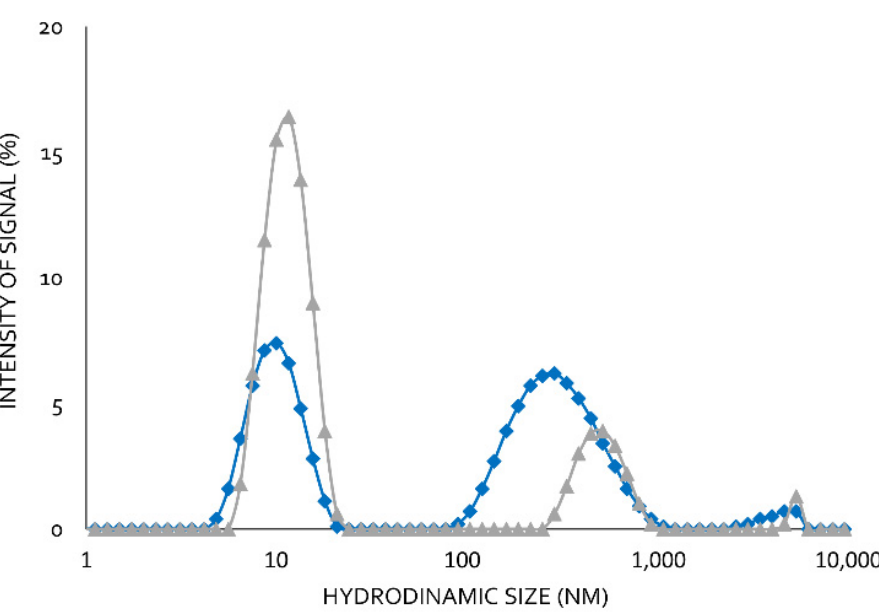
Figure 5. Dynamic light scattering of soluble Lecitase (2 mg/mL). Blue line: the soluble enzyme in the absence of CTAB. Grey line: the soluble enzyme in the presence of 0.2% CTAB.